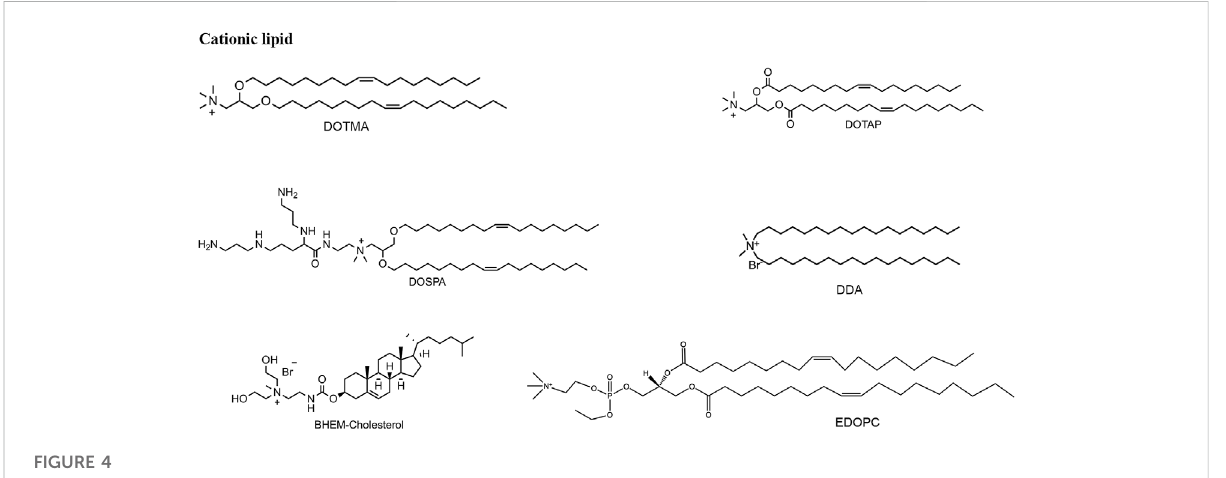
FIGURE 4 Structure of six typical cationic